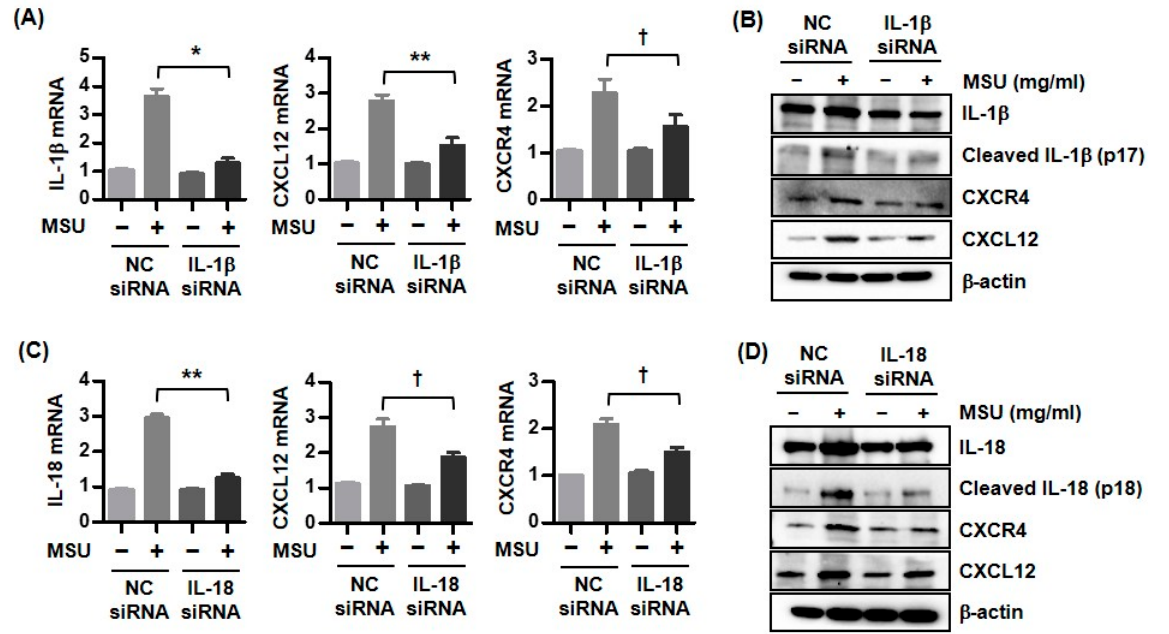
Figure 3. Expression of IL-1 β , IL-18, CXCR4, and CXCL12 in either IL-1 β siRNA- or IL-18 siRNA- transfected U937 cells treated with MSU crystals. ( A , B ) IL-1 β , IL-18, CXCR4, and CXCL12 mRNA and protein expression in IL-1 β siRNA-transfected U937 cells under stimulation of MSU crystals (0.3 mg/mL). ( C , D ) IL-1 β , IL-18, CXCR4, and CXCL12 mRNA and protein expression in IL-18 siRNA-transfected U937 cells under stimulation of MSU crystals (0.3 mg/mL). * p < 0.001, ** p < 0.01, and † p < 0.05 compared with the unstimulated cells. The images are representative of three independent experiments.